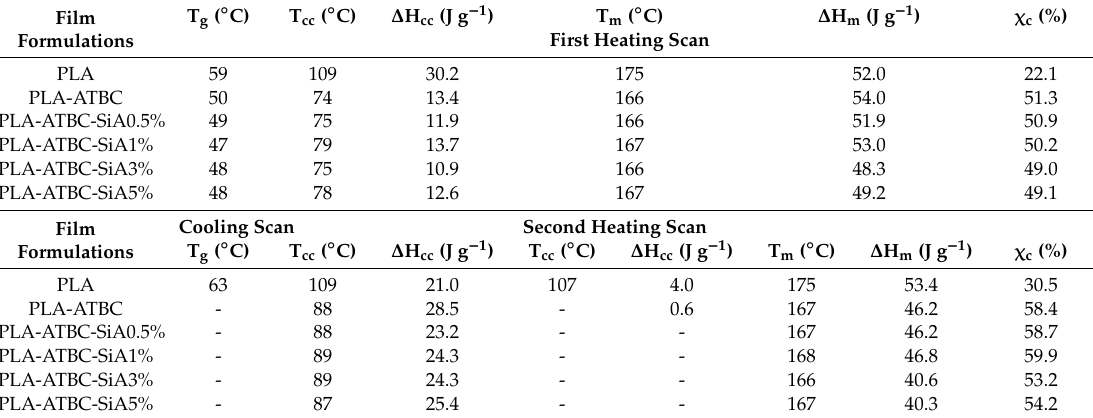
Table 3. Thermal parameters of PLA, PLA-ATBC and hybrid plasticized biocomposite films obtained from DSC during the first heating